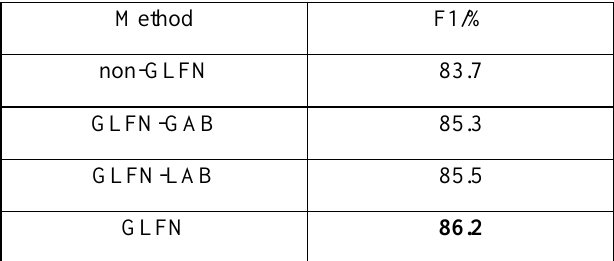
Table 4. The highest F1 values of four methods on